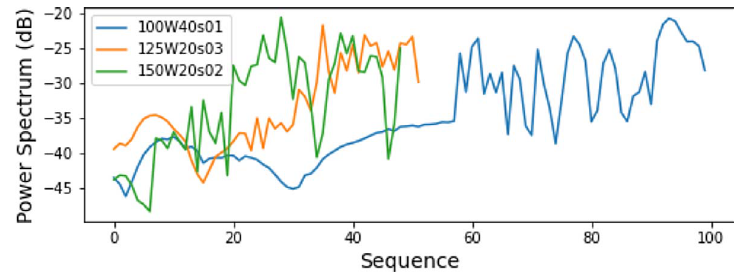
Figure 9. Power spectrum analysis of scattered echo signal with medium and high ultrasonic dose irradiation.